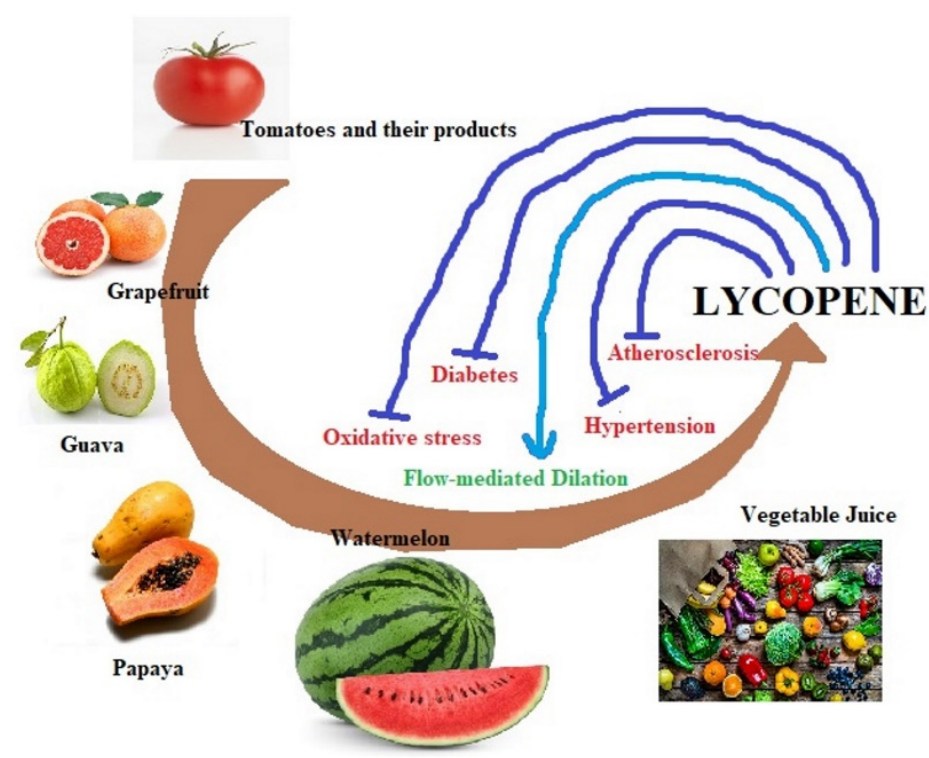
Figure 2. Overview of lycopene sources and its effect on cardiovascular disease factors.